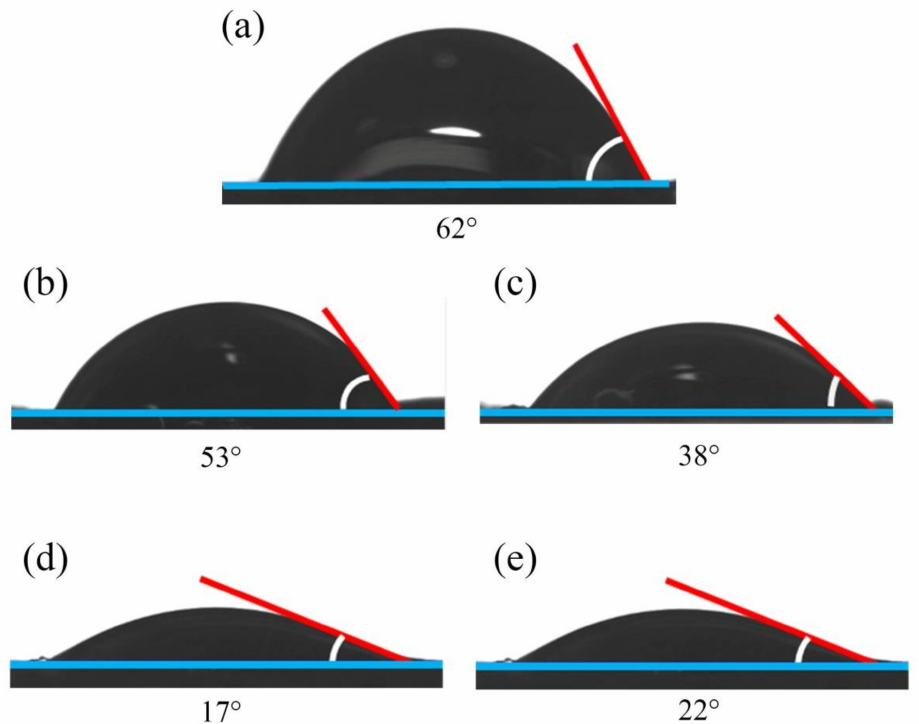
Figure 2. Contact angle measurement of various specimens. ( a ) S–BP; ( b )